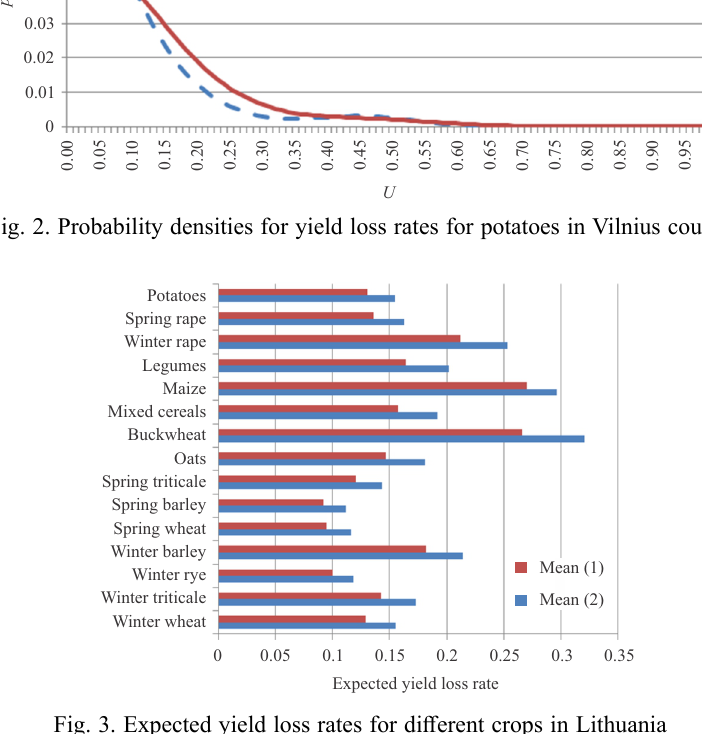
Fig. 3. Expected yield loss rates for different crops in Lithuania